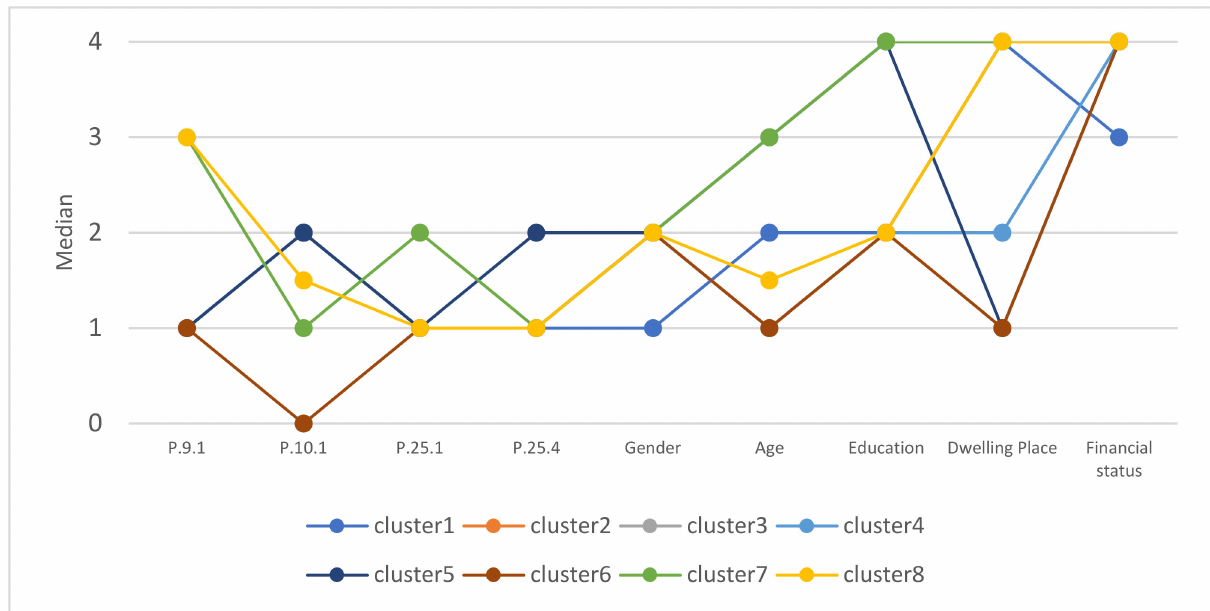
Figure 2. Medians of selected characteristics for observations in different clusters due to both related to the